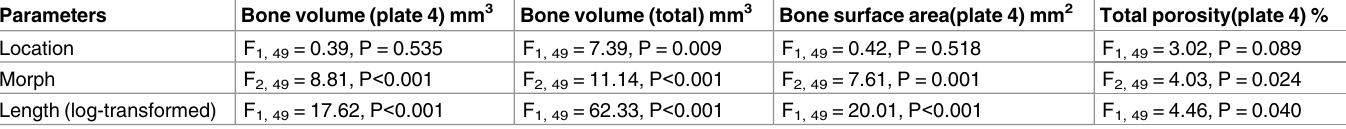
Table 2. Summary statistics for test for differences in trait values for low, partial and complete plated stickleback morphs from Asd ø ltjern and Engervann.